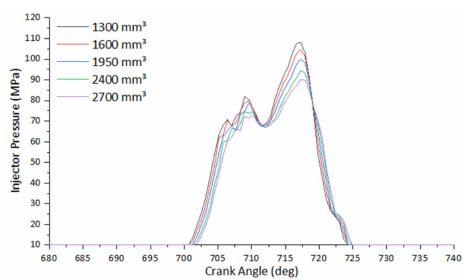
Figure 14. Fuel injection pressure under varied valve volumes.